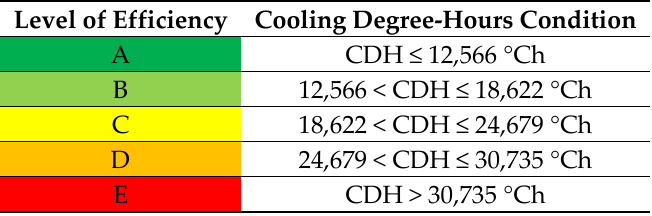
Table 5. Building envelope efficiency according to the Brazilian Residential Buildings